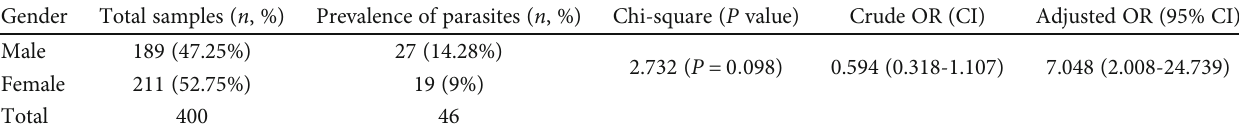
Table 2: Gender-wise distribution of parasitic infection.